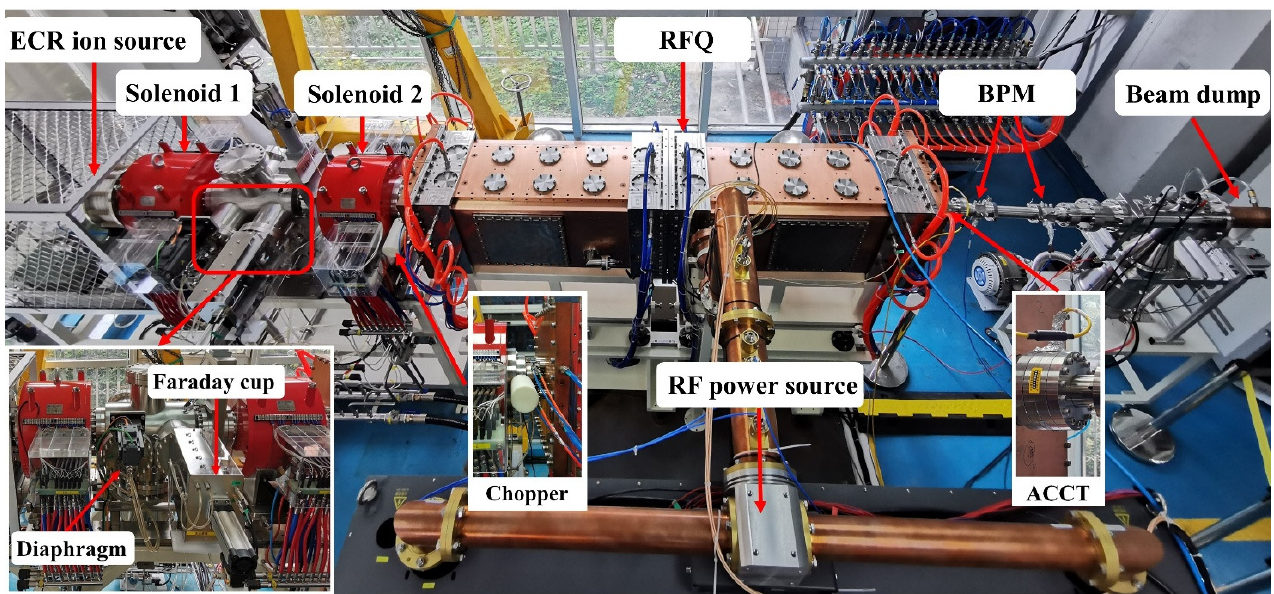
Figure 15. Overview of the RFQ test area.